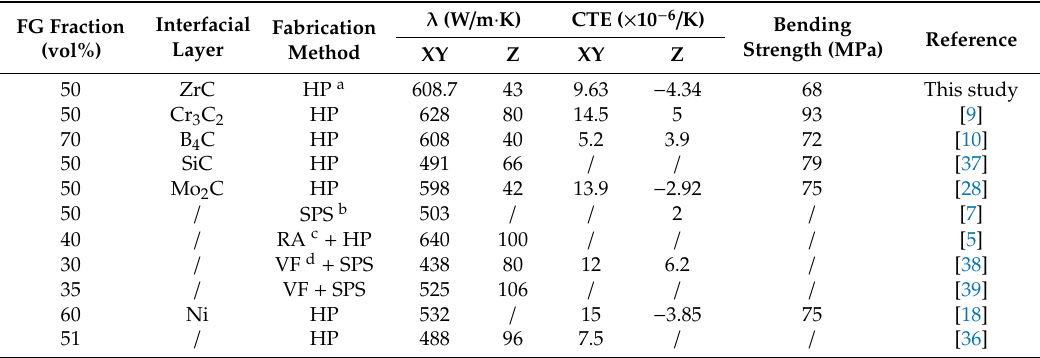
Figure 13. Fracture appearance of FG/Cu-Zr composites with ( a ) 0 wt %, ( b ) 0.5 wt %, ( c ) 1 wt %, and ( d ) 2 wt % Zr. Table 2. Comparisons of the thermal conductivity ( λ ), coe ffi cient of thermal expansion (CTE), and bending strength of FG / Cu composites in this study and previous